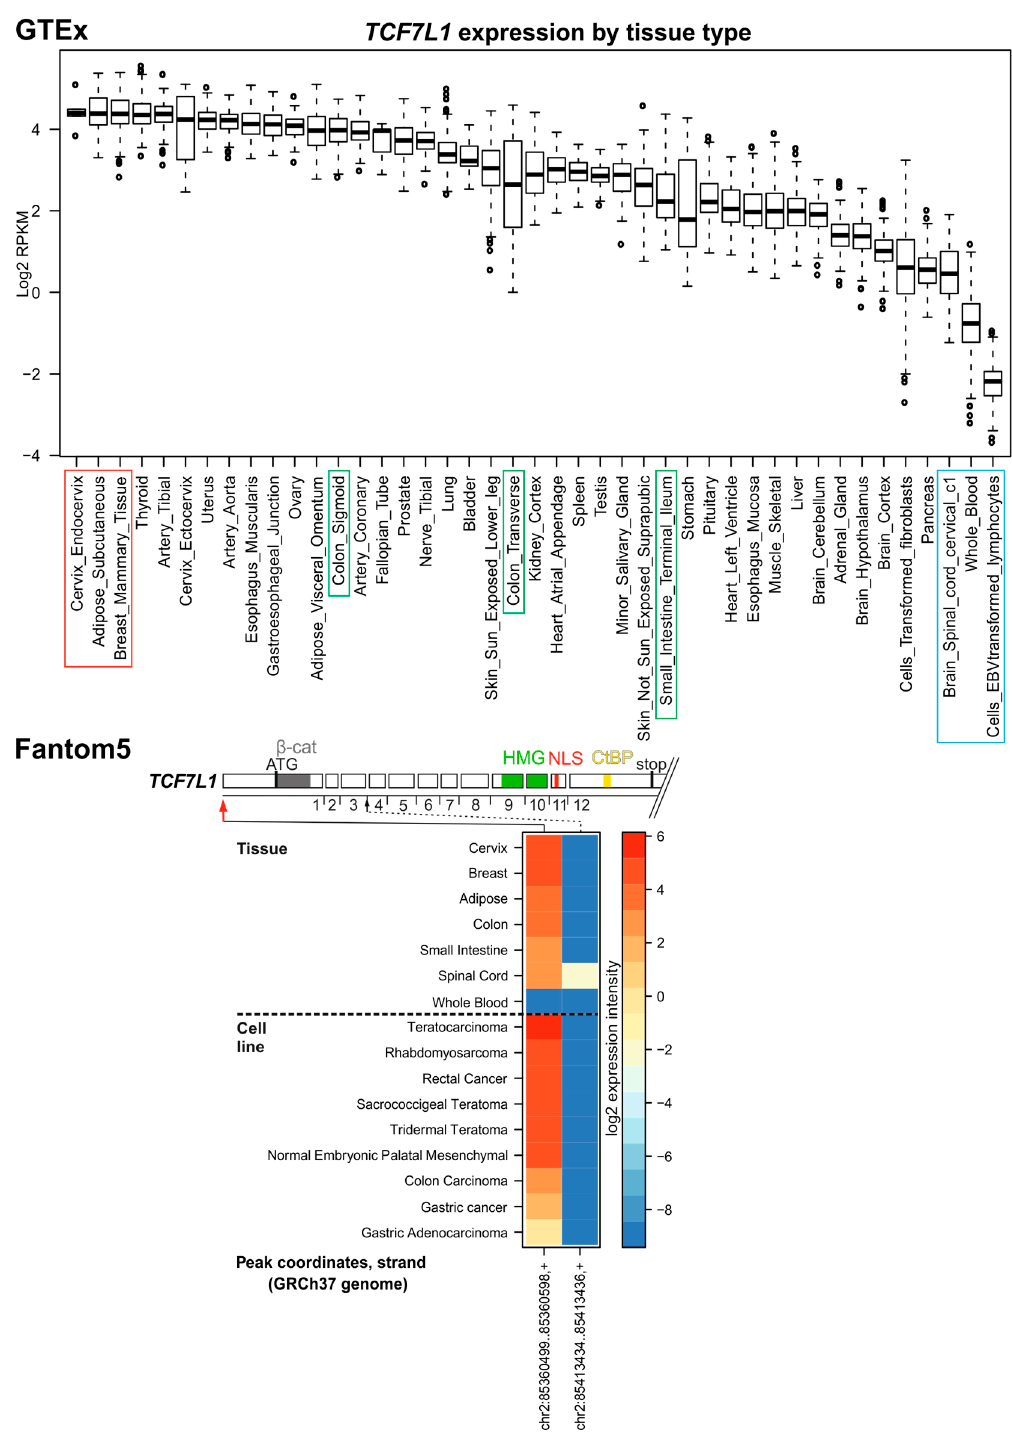
Figure 4. TCF7L1 expression in human tissues and TSS usage. For description, see Figure 2